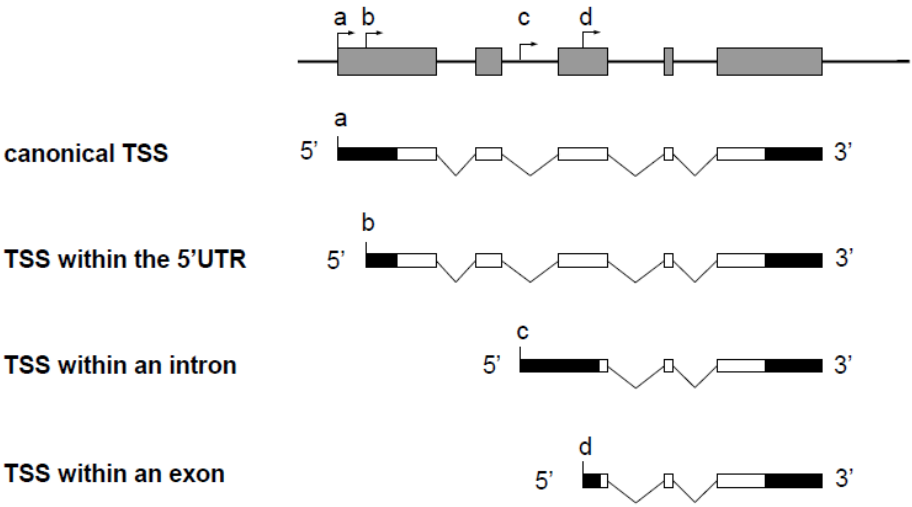
Figure 1. Schematic representation of a spliced gene and transcript isoforms synthesized from multiple TSSs. Exons and introns of the gene are shown as grey boxes and black lines, respectively. Untranslated and translated regions of the transcript isoforms are indicated as black boxes and white boxes, respectively. The TSS of the canonical transcript is located at the position marked (a). Transcripts from a TSS located within an intron (c) possess a unique sequence due to an alternative first exon. In contrast, transcripts from a TSS located within the 5 (cid:48) UTR (b) or within an exon (d) do not possess unique sequence compared to the canonical